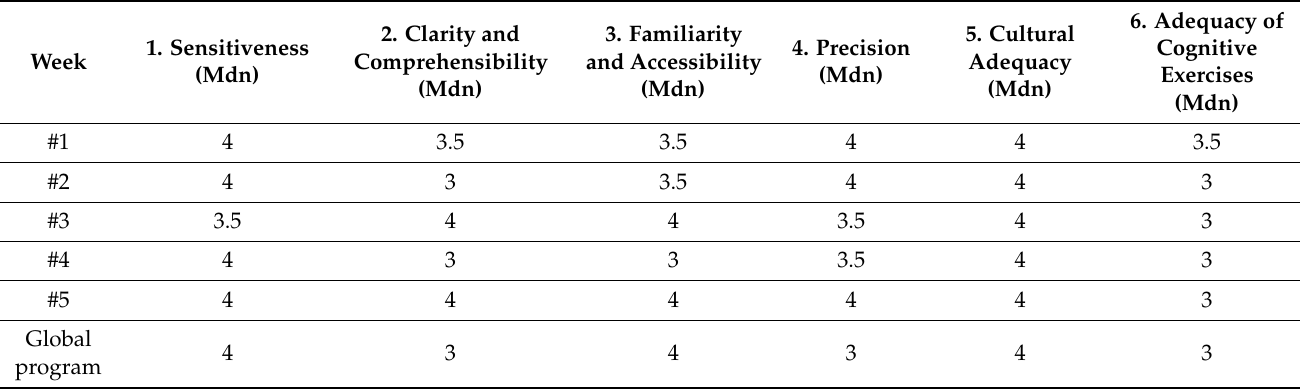
Table 3. Expert panel quantitative appraisal for each session/global program of the UCLA program concerning six